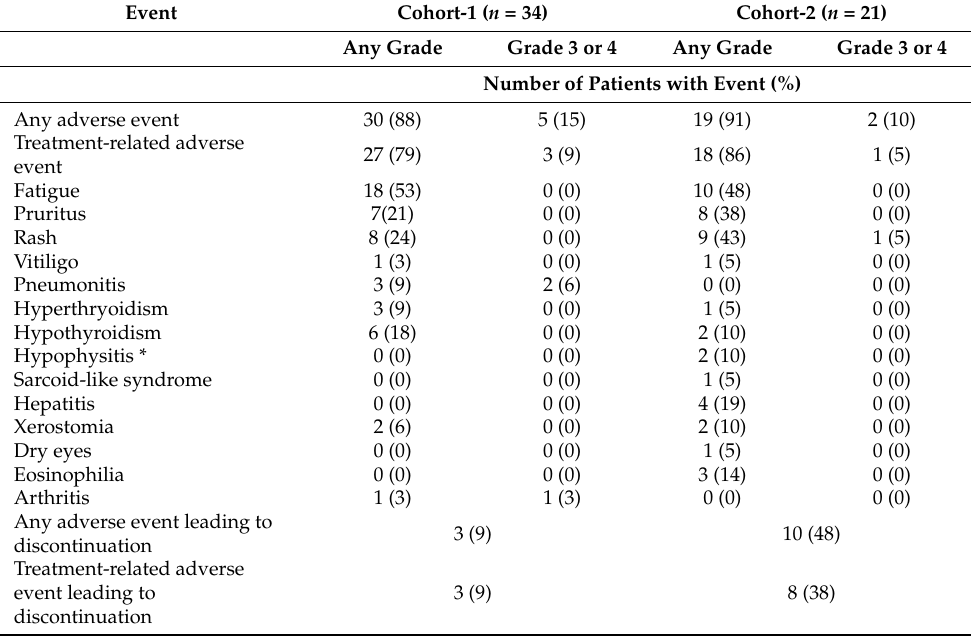
Table 2. Adverse Events.